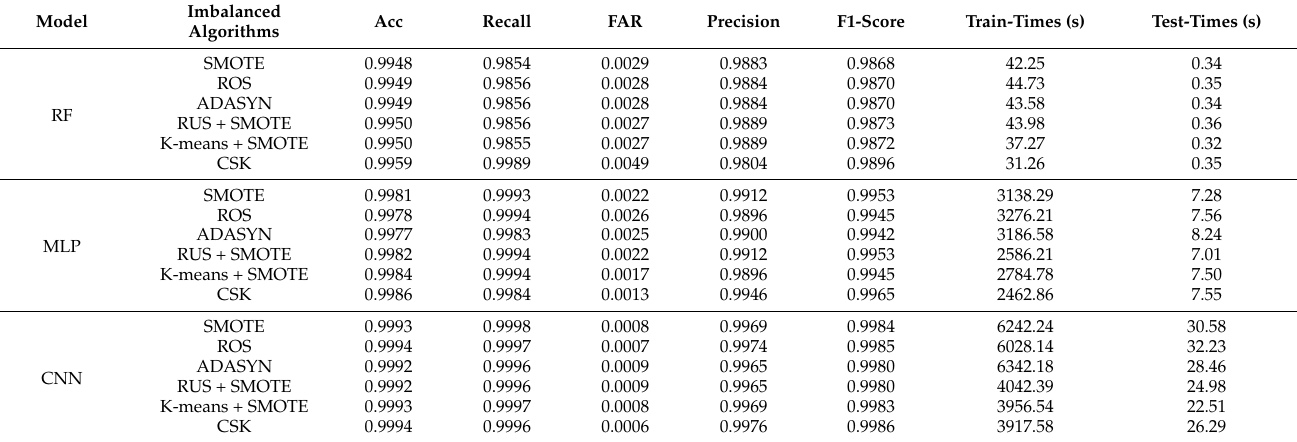
Table 6. Performance Results of Binary Classification on CICDS2017 Dataset.